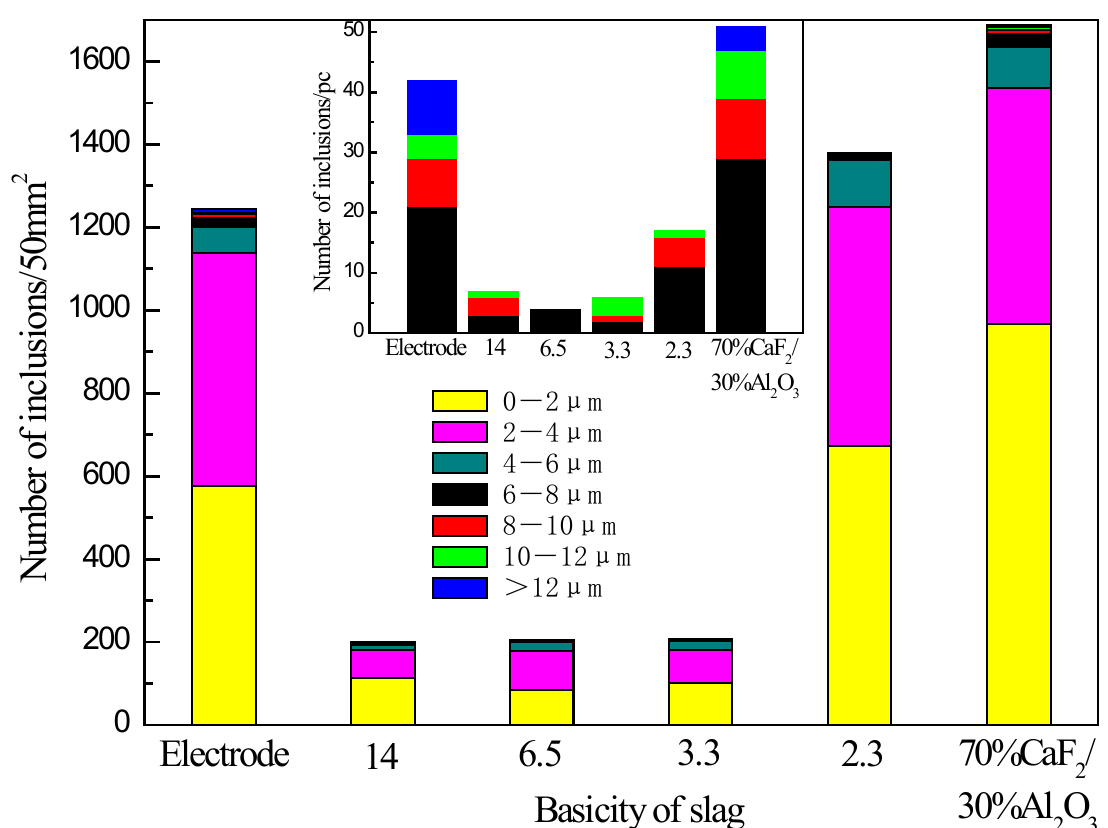
Figure 4. Effect of basicity on the number and size of inclusions.